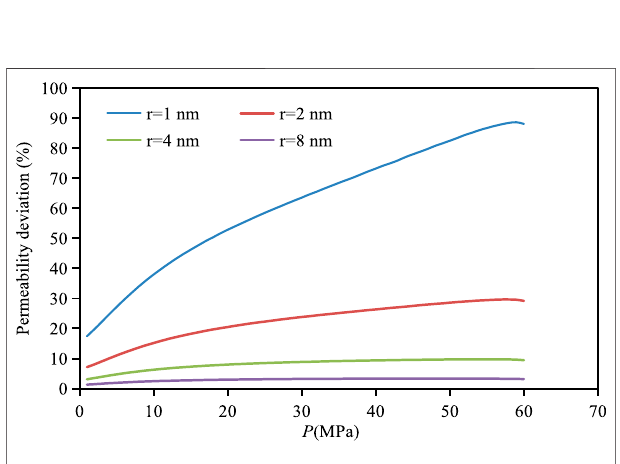
FIGURE 12 | The in fl uence of con fi nement effect on apparent permeability for different pore radius.